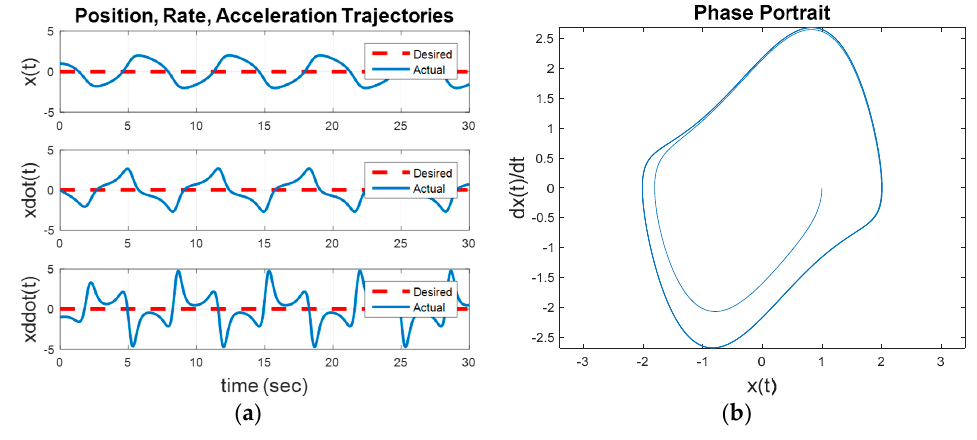
Figure 3. Initial baseline for evaluation. ( a ) Displays trajectory comparison; and ( b ) trajectory.